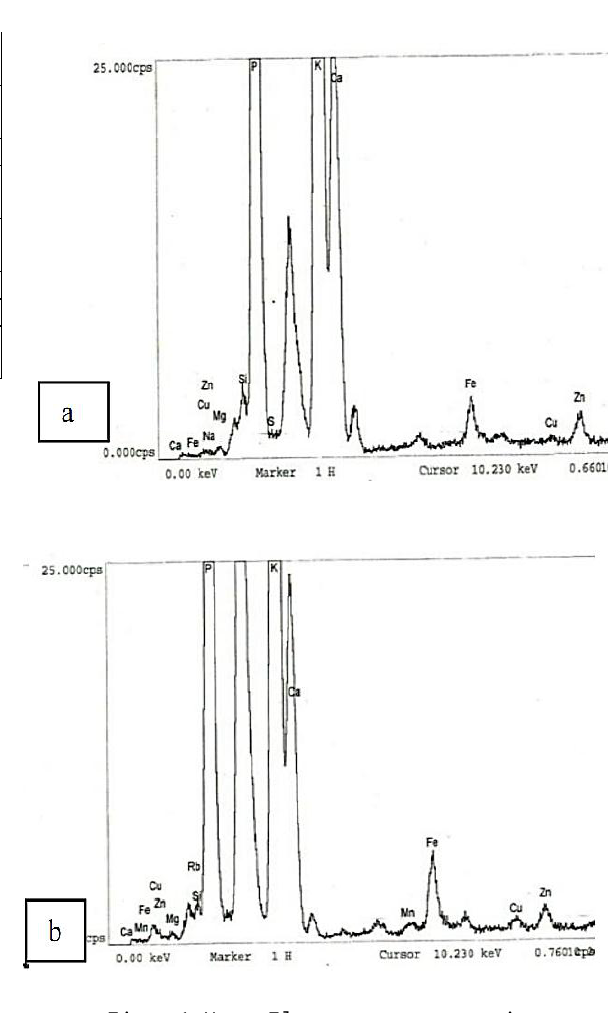
The contents of free and protein amino